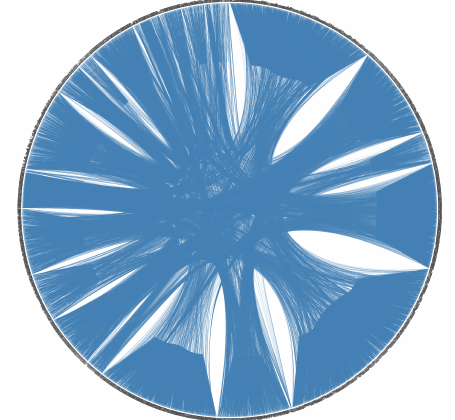
Figure A9. Representation of the whole Facebook data-set using hierarchical edge bundling